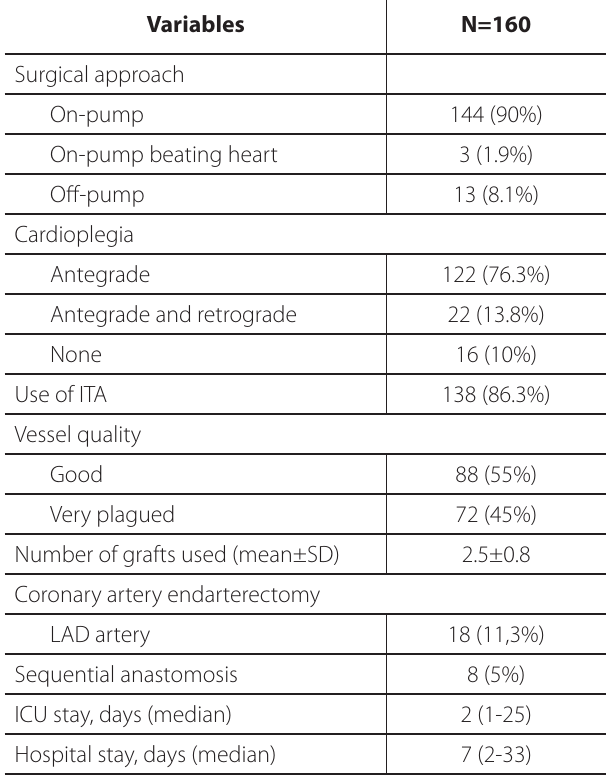
Table 2 . Intraoperative